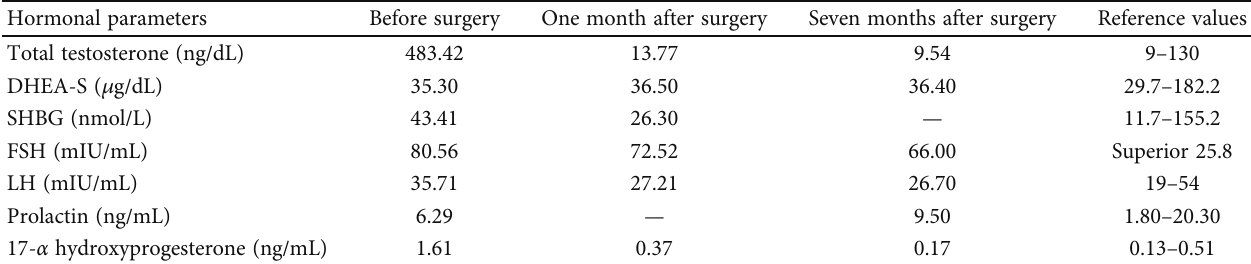
Table 2: Laboratory tests prior to and following surgery in a 64-year-old woman diagnosed with ovarian hyperthecosis. Hormonal parameters Before surgery One month after